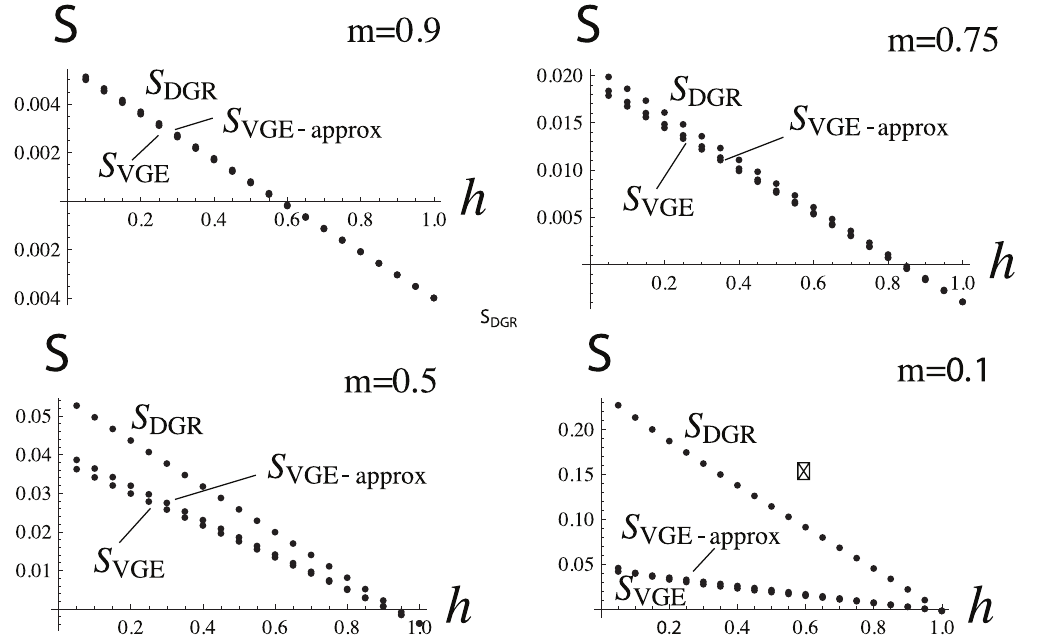
Figure 3. Selection gradient S on belligerence for the DGR and VGE scenarios as a function of h . The functional relationships used are C x ( x ) ~ x 4 , w given by eq. 4 with a ( x ) ~ x , and g ( e ) ~ e c , and the resident trait value was set to x ~ 1 . The parameter values are N ~ 5 , v ~ 0 : 5 , and the value c takes does not affect the selection pressure on belligerence. Further, m ~ 0 : 9 in the top right panel, m ~ 0 : 75 in the top left panel, m ~ 0 : 5 in the lower right panel, and m ~ 0 : 1 in the lower left panel. The top line in each panel is eq. 21; that is, the selection gradient for the DGR scenario and denoted by S DGR . The second line in each panel is S f z S Pr with eq. B-18 of Appendix S2 using z ~ x and eq. B-20 of Appendix S2; the selection gradient for the VGE without making any assumption on the value h can take, which is denoted by S VGE . The last line in each panel is eq. B-36 of Appendix S2; the selection gradient for the VGE assuming that h is small and is denoted by S VGE { approx . Three observations follow from this figure, which were also observed under a wider range of numerical exploration. First, for strong migration rates all three selective pressures agree. Second, for low migration rates the selective pressure is stronger under the DGR than under the VGE scenario for all values of h . Third, the small h approximation of the VGE scenario underestimates the strength of selection on belligerence when migration is low, but the approximation works quiet will for h w 0 : 5 . Similar results were observed if the contest success function is of the difference form.